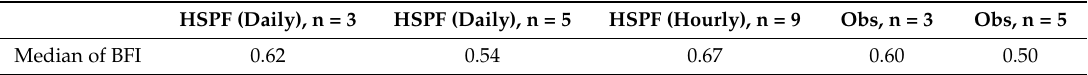
Figure 14. Baseflow extracted from hourly HSPF output ( a ) and the BFI estimated from the hourly output following the method in [41] ( b ). Table 13. Baseflow index (BFI) computed from hourly and daily streamflow simulation.